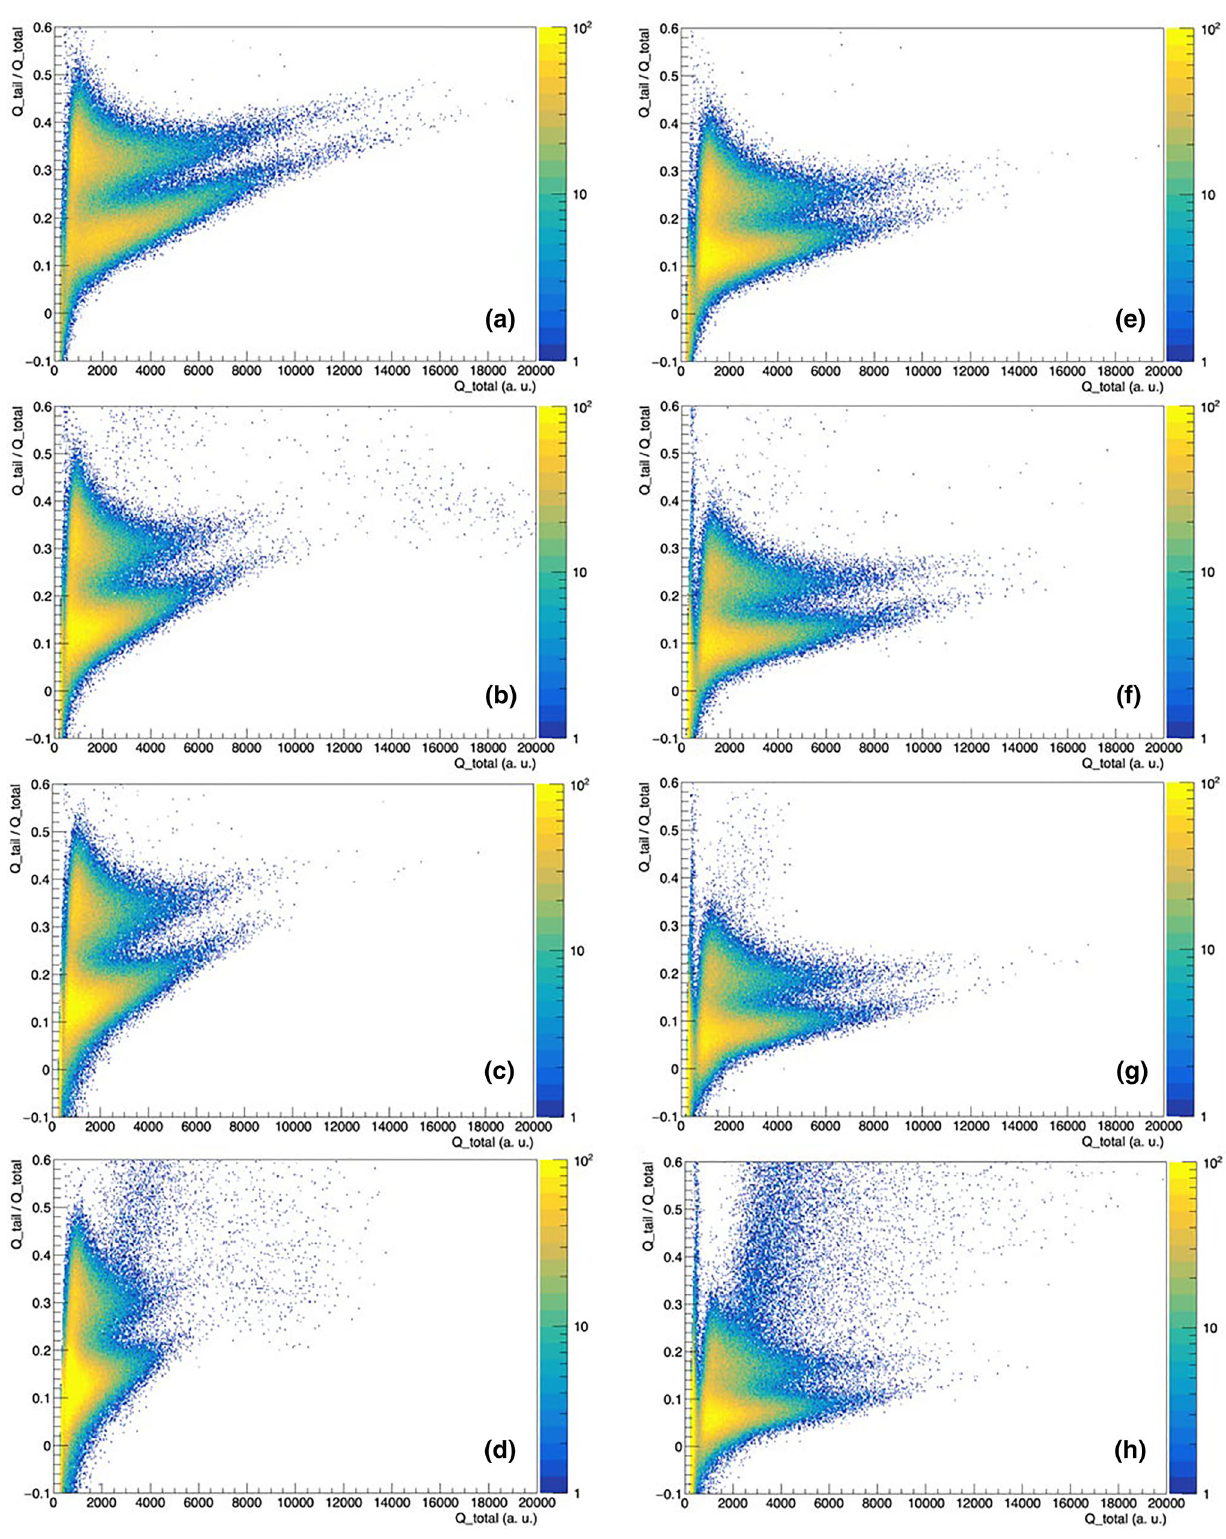
Fig. 7 2D plots (pulse shape discrimination parameter versus total integral) corresponding to the standard EJ-299 at a room temperature, b 70 ◦ C, c 100 ◦ C, d 120 ◦ C, and PMPS based scintillator with 6% PPO at e room temperature, f 70 ◦ C, g 100 ◦ C, h 120 ◦